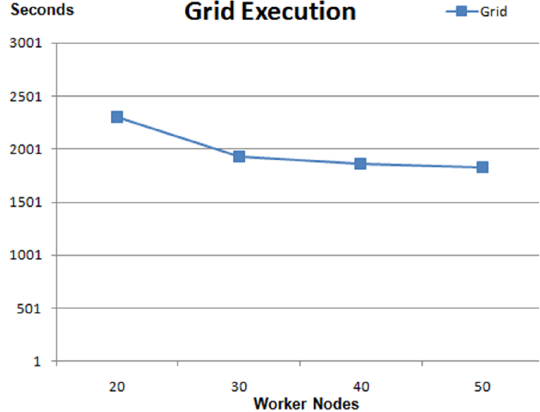
Fig. 10. Danube 1 total calibration time over the grid.